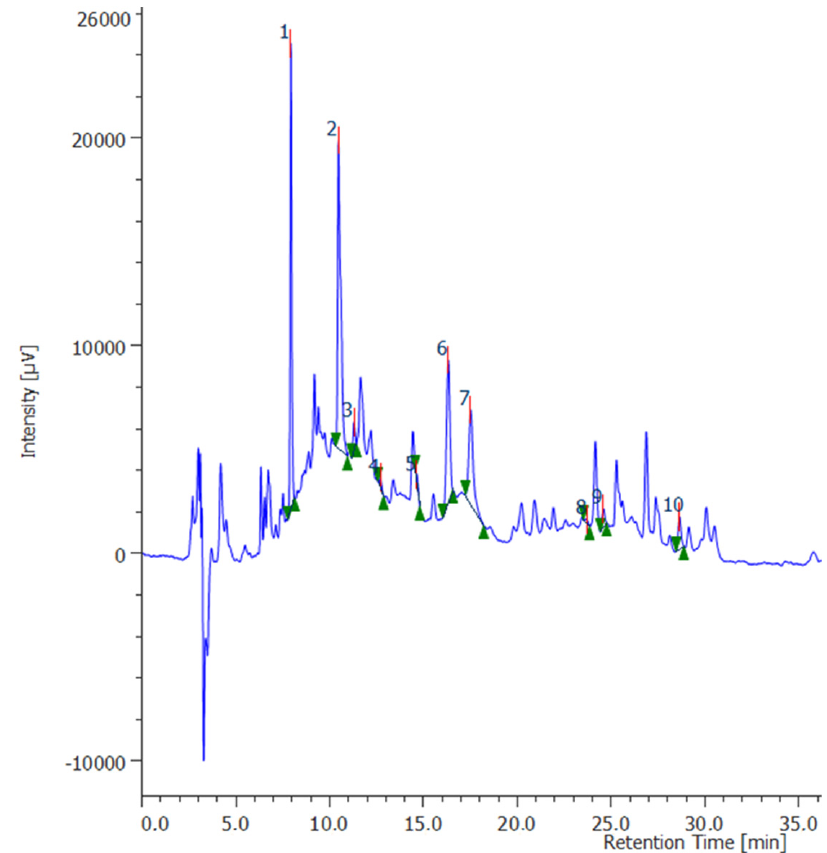
Figure 1. Chromatographic analysis of grape pomace phenolic compounds. The chromatographic analysis confirmed the presence of different phytochemicals: gallic acid (peak #1); caftaric acid (peak #2); catechin (peak #3); chlorogenic acid (peak #4); epicatechin (peak #5); caffeic acid (peak #6); syringic acid (peak #7); coumaric acid (peak #8); ferulic acid (peak # 9).